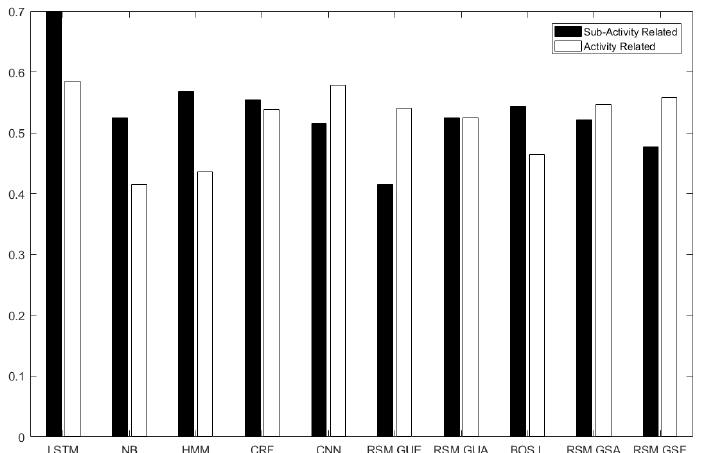
Figure 7. AUC histogram for the proposed methods and the comparison